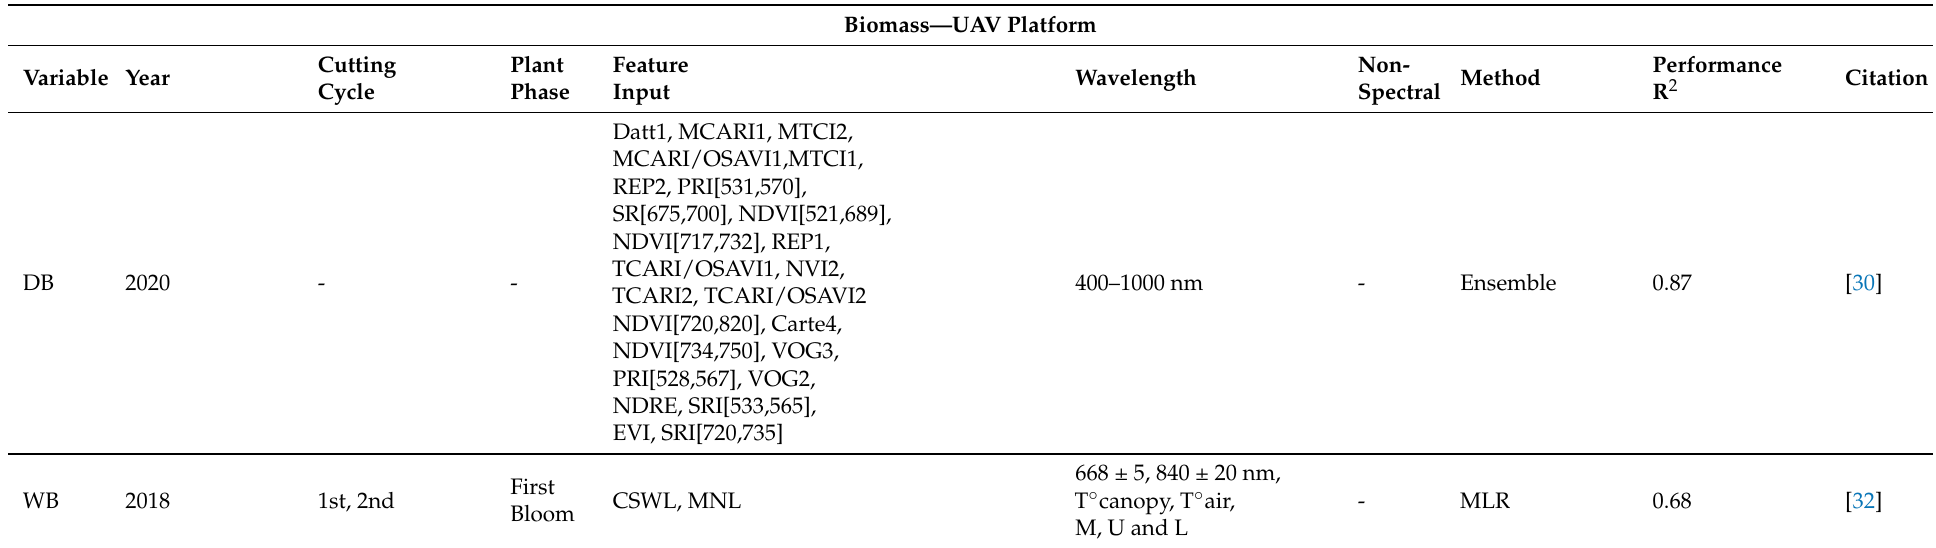
Table A2. Most accurate features for predicting alfalfa biomass using UAV